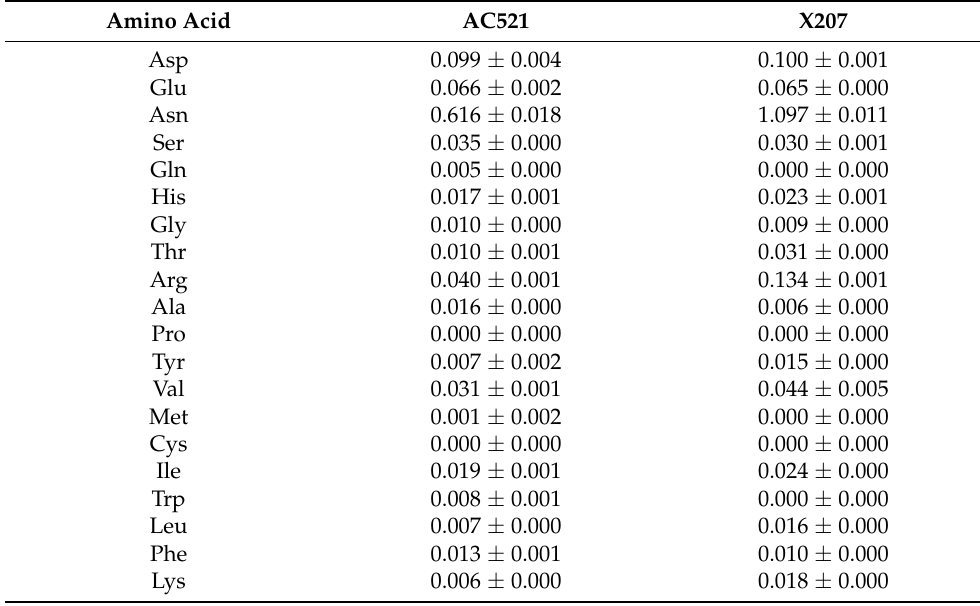
Table 6. Free amino acids in roots of ahipa AC521 and the interspecific P. ahipa × P. tuberosus hybrid X207. Means in g × 100 g dry weight − 1 ± standard